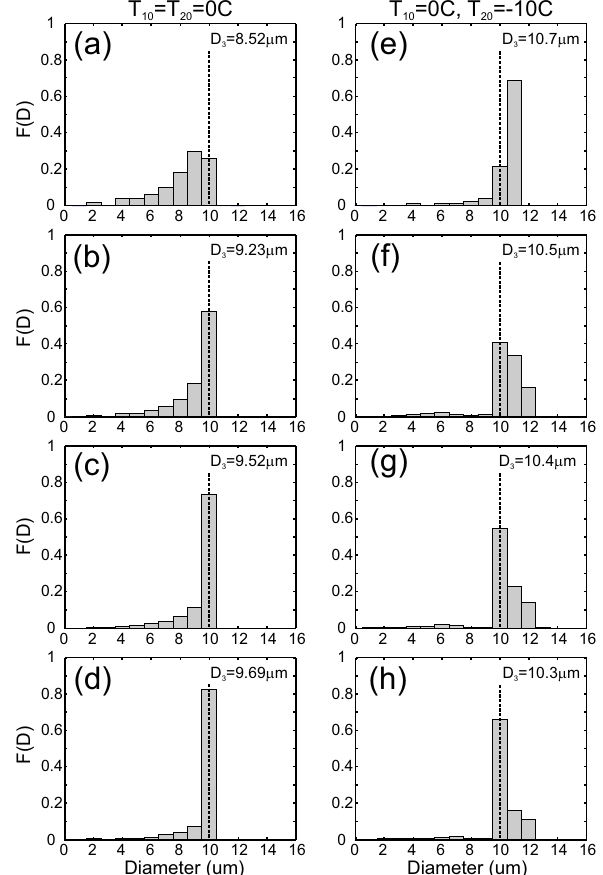
Figure 11. Droplet size distributions formed during the progressive homogeneous mixing corresponding to the (a, e) primary stage; (b, f) 2nd stage; (c, g) 3rd stage; (d, h) 4th stage. Left column (a, b, c, d) corresponds to the case when the cloud temperature is equal to the dry air temperature T 1 = T 2 = 0 ◦ ; right column (e, f, g, h) corresponds to the case when T 1 = 0 ◦ , T 2 = − 10 ◦ . For both cases the simulation was performed for D 1 = 10µm; N = 500cm − 3 ; RH 2 = 0 .